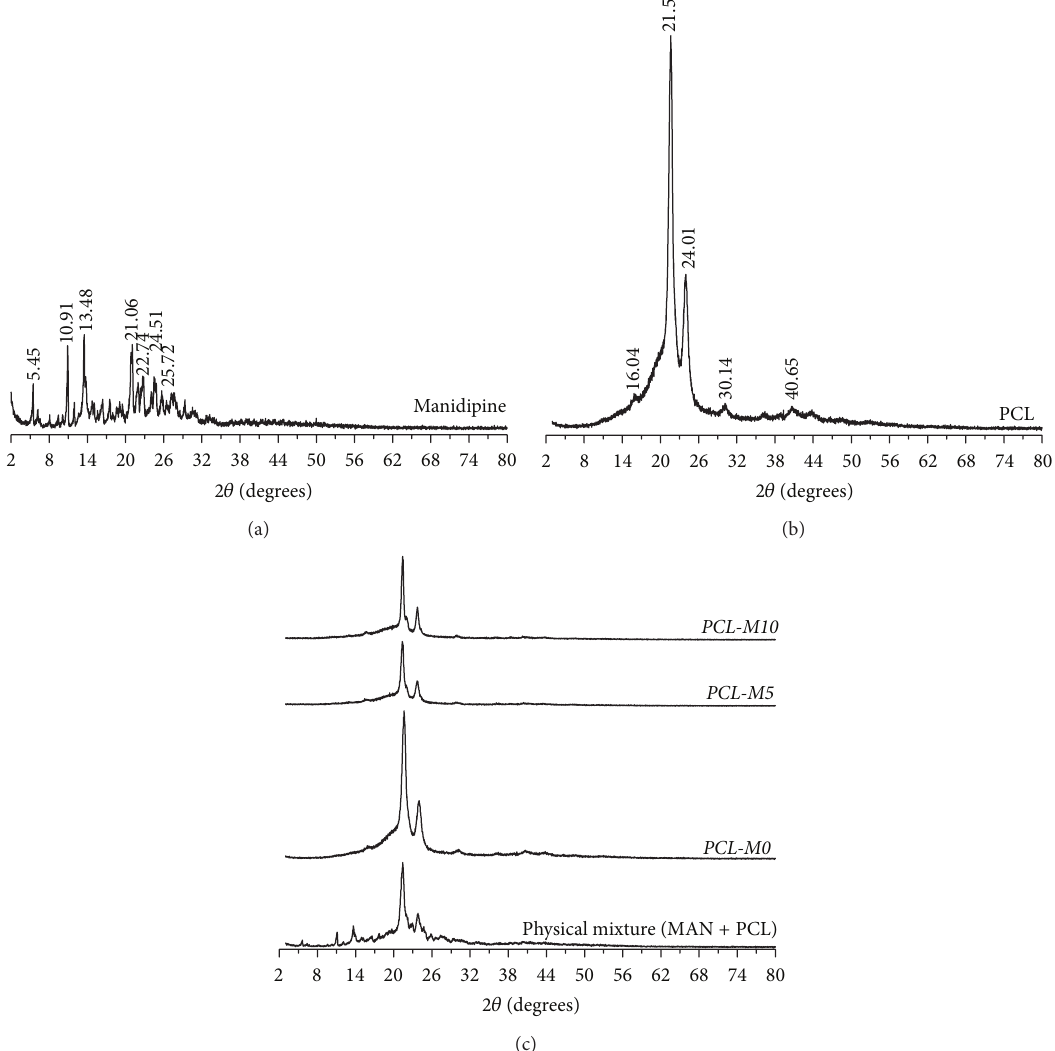
Figure 3: X-ray diffractions spectra of MAN, PCL, physical mixture (MAN + PCL), and PCL microparticles.